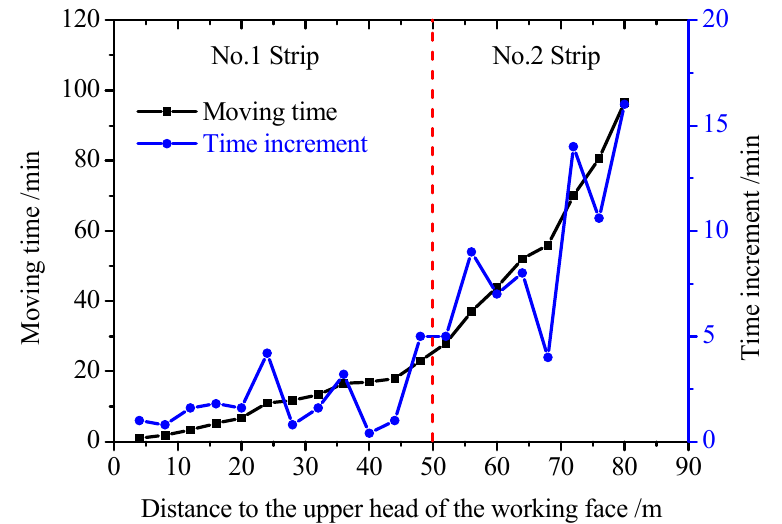
Figure 12. Gangue moving time variation curve at the double strip mining stage of the working face.